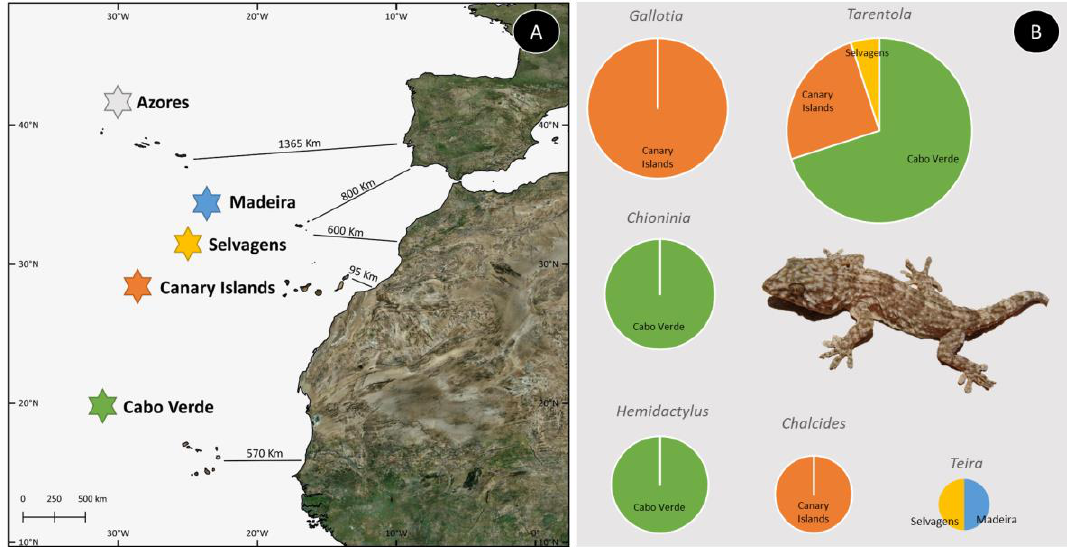
Figure 1. The five archipelagos of the Macaronesian region—Azores, Madeira, Selvagens, Cabo Verde and Canary Islands—with the corresponding distance to the closest mainland point ( A ), and the diversity of endemic Squamata reptile taxa within this region ( B ): Chalcides (coeruleopunctatus, sexlineatus, simonyi and viridanus ), Chioninia (delalandii, fogoensis, nicolauensis, spinalis boavistensis, spinalis maioensis, spinalis salensis, spinalis santiagoensis, spinalis spinalis, stangeri, vaillanti vaillanti and vaillanti xanthotis), Gallotia (atlantica mahoratae, atlantica atlantica, atlantica laurae, auaritae, bravoana, caesaris caesaris, caesaris gomerae, galloti eisentrauti, galloti galloti, galloti insulanagae, galloti palmae, intermedia, simonyi machadoi and stehlini ), Hemidactylus (bouvieri bouvieri, bouvieri ssp., bouvieri razoensis, boavistensis and lopezjuradoi ), Tarentola (angustimentalis, bischo ffi , boavistensis, bocagei, boettgeri boettgeri, boettgeri hierrensis, caboverdiana caboverdiana, caboverdiana raziana, caboverdiana substituta, darwini, delalandii, gigas gigas, gigas brancoensis, fogoensis, gomerensis, maioensis, nicolauensis, protogigas protogigas, protogigas hartogi and rudis), and Teira dugesii . The three extinct taxa ( Chioninia coctei, Gallotia goliath and Gallotia simonyi simonyi ) were not included in this representative analysis. Photo of Tarentola maioensis by R. Vasconcelos.